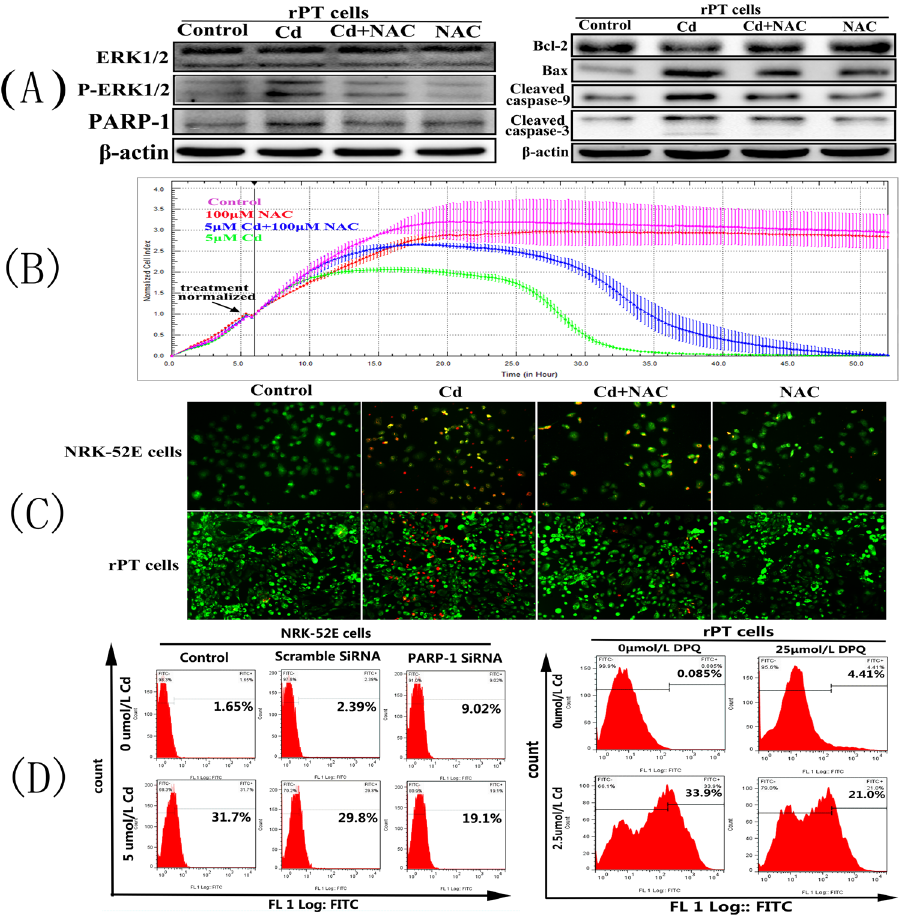
Figure 9. C d-induced oxidative stress and the effect of parthanatos on reactive oxygen species (ROS) in cells. ( A ) NAC significantly reduced the expression of related apoptotic proteins in primary rPT cells. ( B ) NAC attenuates the effect of Cd on NRK-52E cells proliferation. ( C ) AO-EB staining showed that NAC significantly reduced the Cd-induced cell apoptosis and death (200 × ). ( D ) Inhibition of PARP-1 overexpression or silencing its gene reduced the ROS content